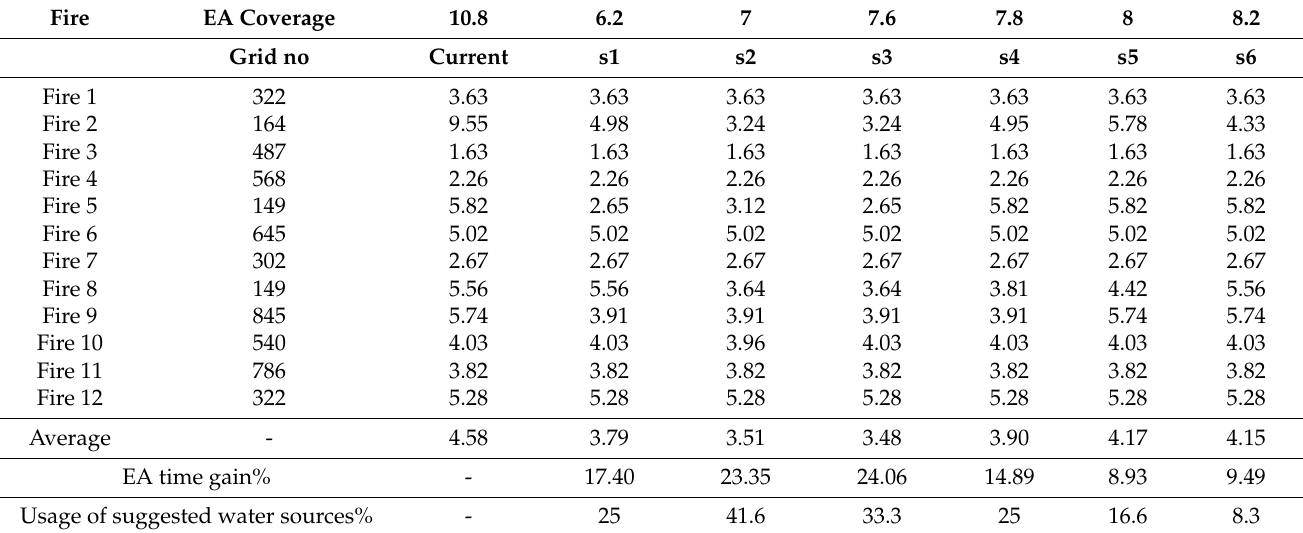
Table 6. EA times in all solutions for historical